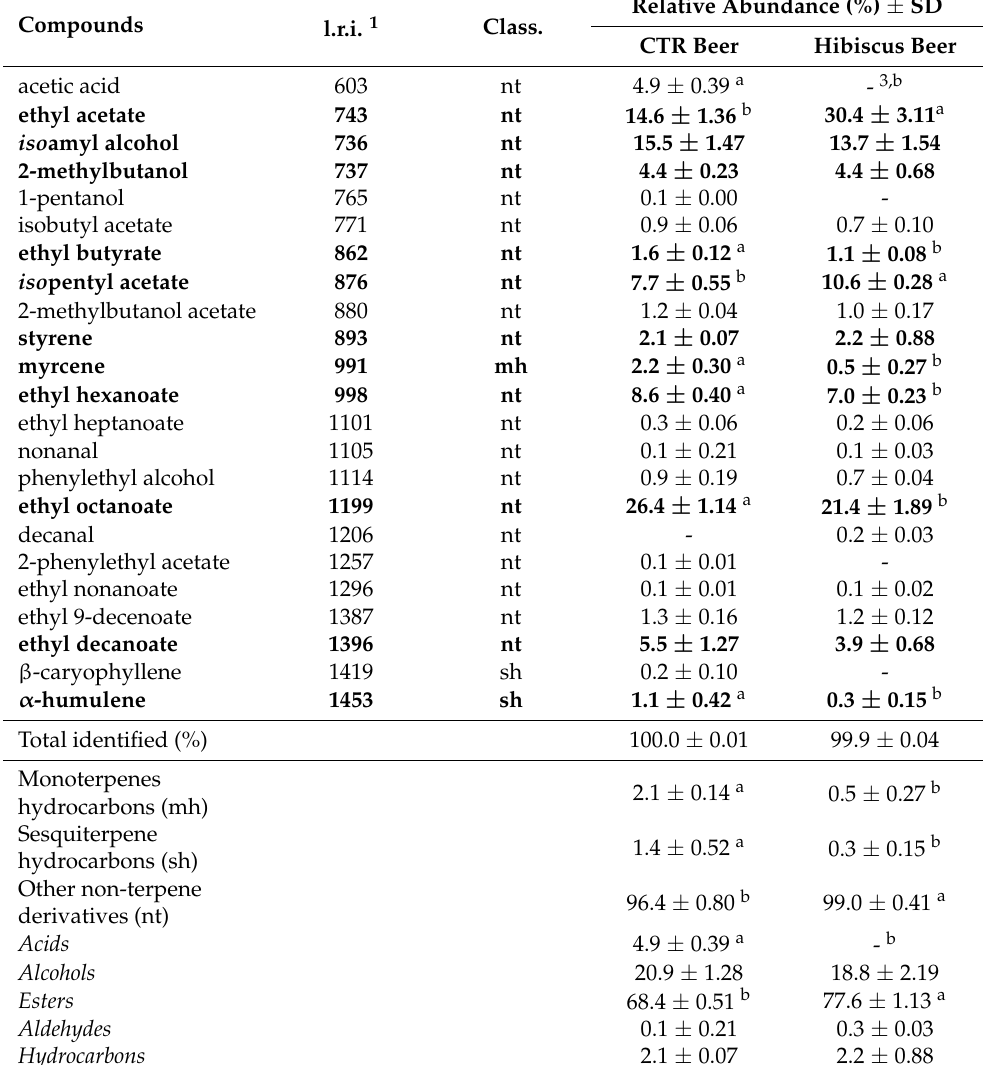
Table 4. Chemical composition of the headspaces of the beer